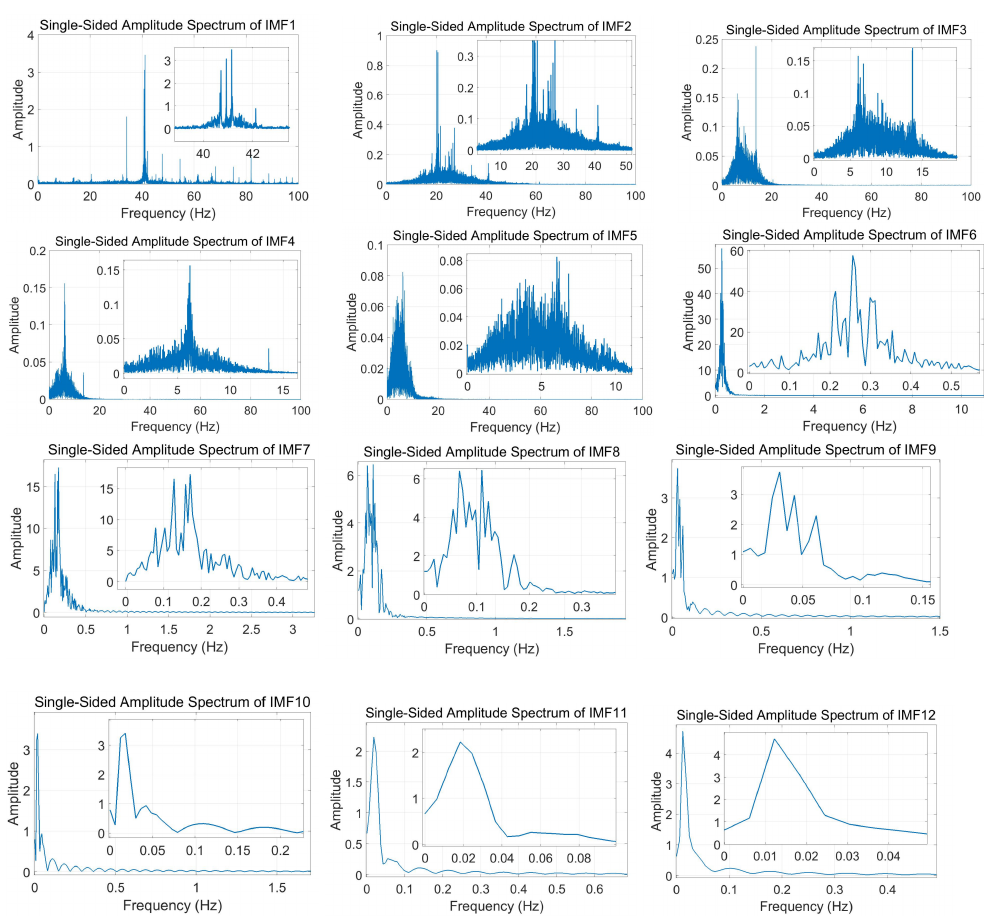
Figure 8. Statistical curve of the IMF component spectrum analysis after MEEMD decomposition. By analyzing the frequency domain of the IMF component, the frequency of IMF1 and IMF6 is the same as that of the interference component. The signal is reconstructed after removing the interference components of IMF1 and IMF6. The reconstructed signal spectrum is shown in Figure